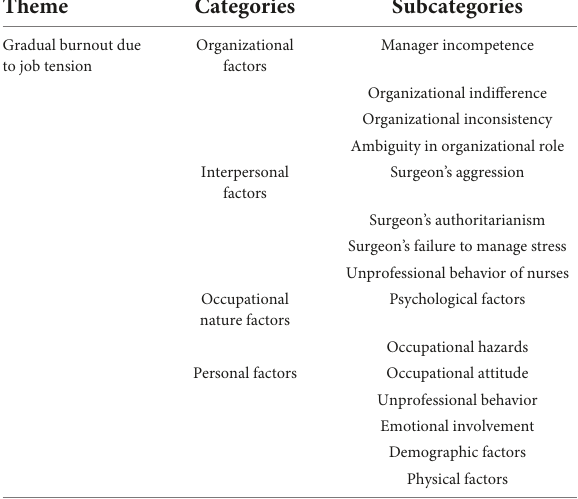
TABLE 3 Theme, categories, and